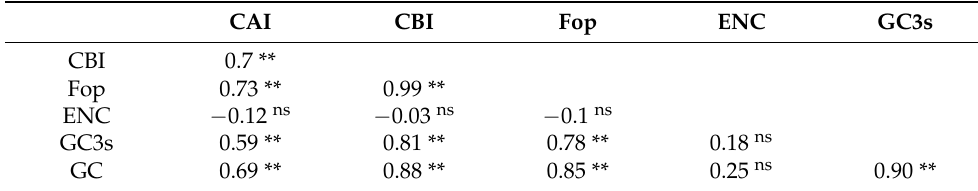
Table 3. The correlation coefficient between the parameters of codon usage of Brassica LysM-RLK gene